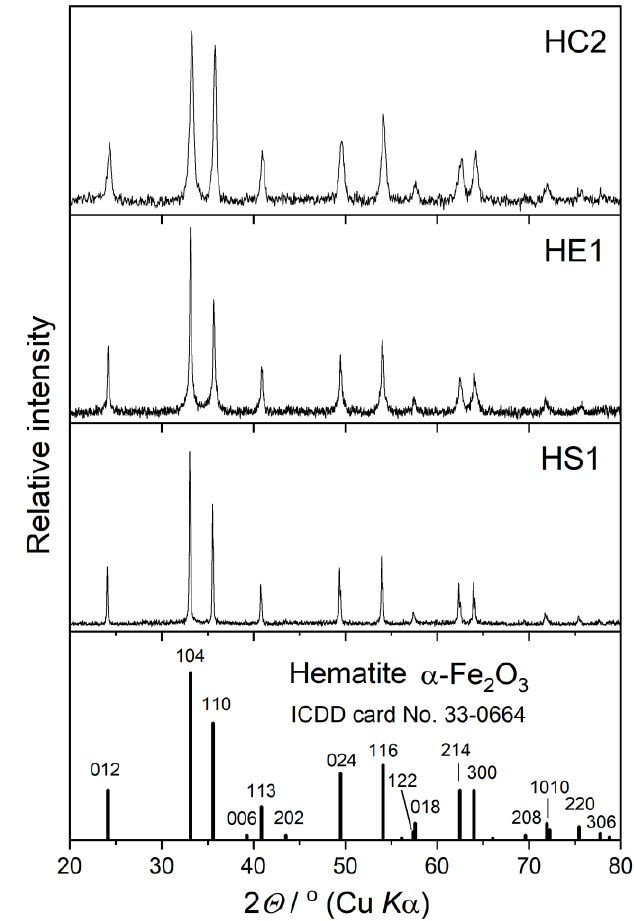
Figure 3. PXRD patterns of synthesized hematite samples, HC2, HE1, and HS1, with the positions and intensities of the diffraction lines given in the ICDD card of hematite.